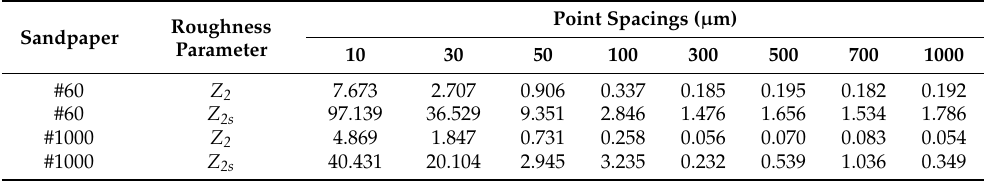
Table 3. Results of average roughness parameters at different point spacings.